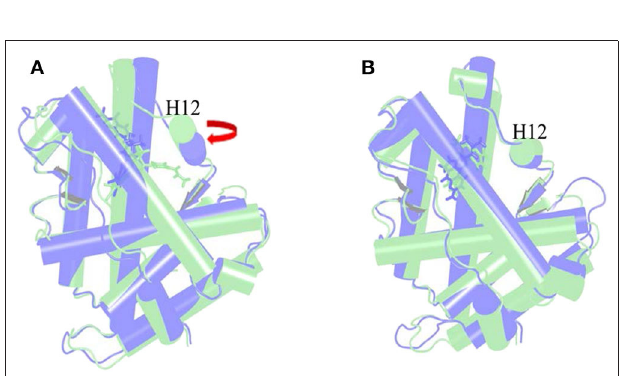
FIGURE 6 | Overlay of wild type androgen receptor and mutant androgen receptor. (A) is the superposition of Enz wild-type system and mutant system. Green indicates the wild-type Enz/WT AR system, and blue indicates the mutant Enz/F876L AR system. (B) is the superposition diagram of the wild-type system and the mutant system of Mol_11. green indicates the wild-type Mol_11/WT AR system, and blue indicates the mutant Mol_11/F876L AR system.